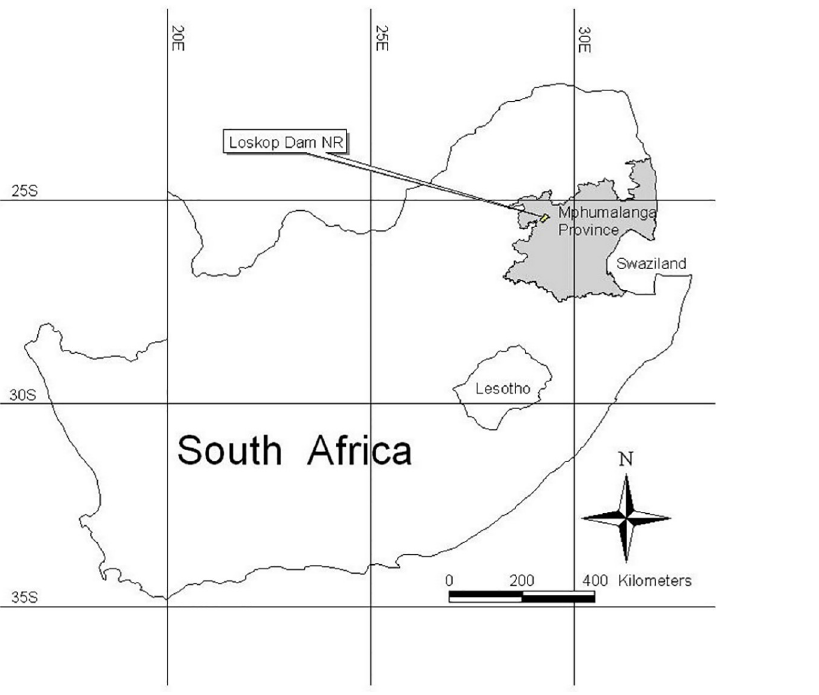
Fig 1. Location of the LDNR within the Mpumalanga province of South Africa